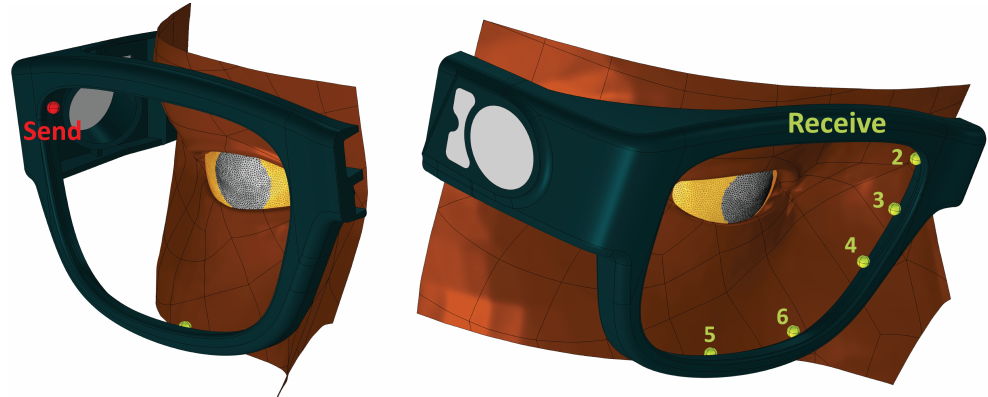
Figure 1. Physical layout for our model. Send location: transducer operating in transmit mode; numbered locations: transducers operating in receive mode. The distance traveled by a ray starting at the send position, reflecting off the cornea, and arriving at receiver 4 is in the 5.28 to 5.35 mm depending on